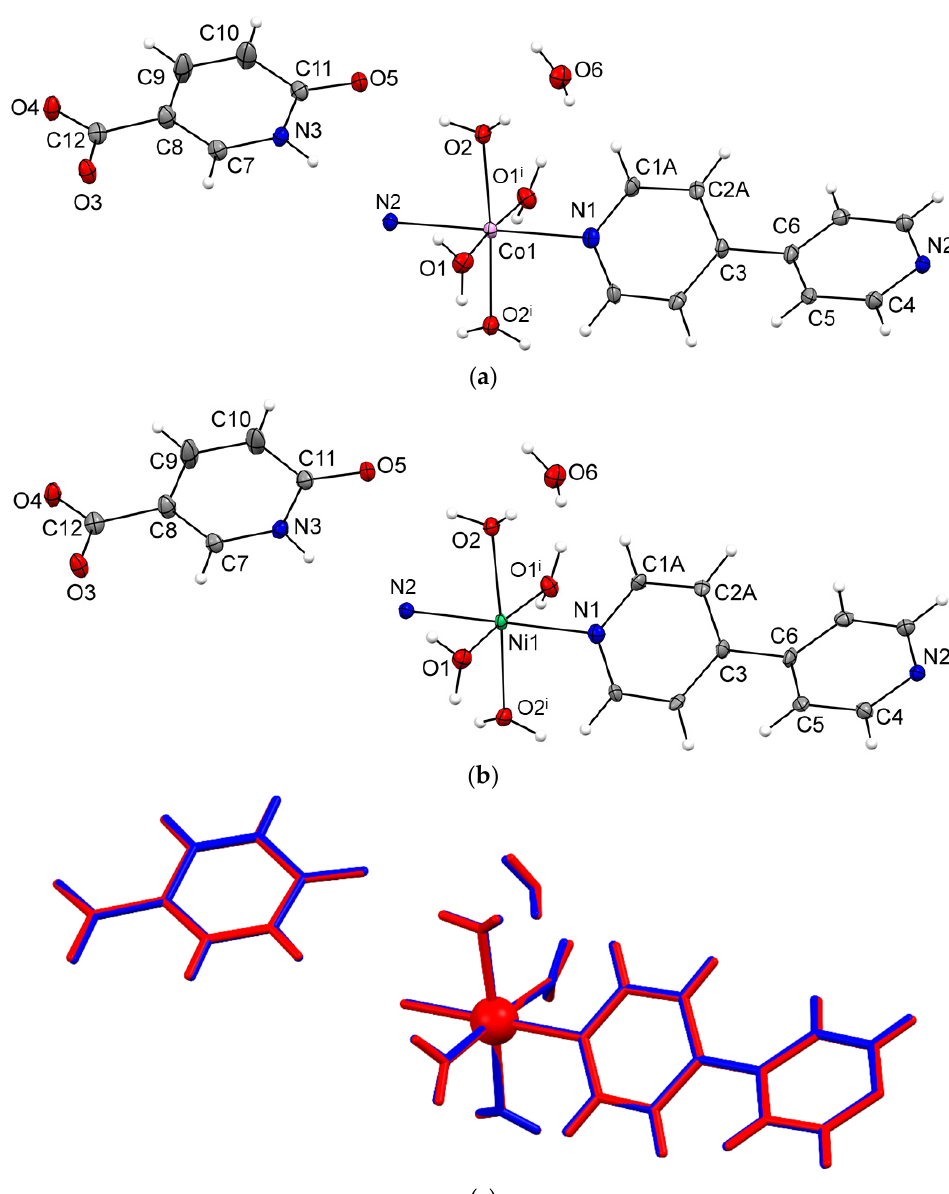
Figure 1. ORTEP-style plots of {[Co(4,4 ′ -bpy)(H 2 O) 4 ](6-Onic) 2 ·2H 2 O} n ( 1 ) ( a ) and {[Ni(4,4 ′ - bpy)(H 2 O) 4 ](6-Onic) 2 ·2H 2 O} n ( 2 ) ( b ), with the atomic numbering schemes (symmetry code (i): − x +1, y , − z +3/2). The thermal ellipsoids are drawn at the 50% probability level at 100(2) K and hydrogen atoms are shown as spheres of arbitrary radii; the components of the disordered C1 and C2 atoms in 1 and 2 (C1B and C2B) are not shown. The overlay (RMS value of 0.0447 Å) ( c ) of {[Co(4,4 ′ - bpy)(H 2 O) 4 ](6-Onic) 2 ·2H 2 O} n ( 1 ) (red) and {[Ni(4,4 ′ -bpy)(H 2 O) 4 ](6-Onic) 2 ·2H 2 O} n ( 2 ) (blue). The Co, Ni, N, and O atoms were chosen for the overlay.